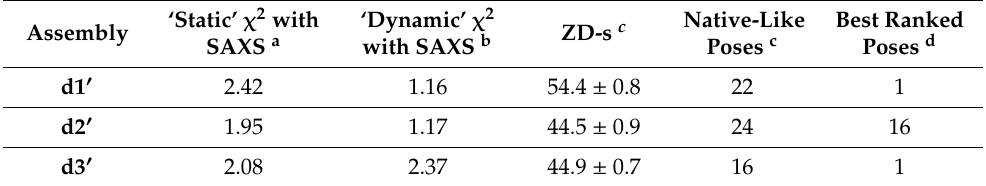
Table 2. Agreement with SAXS data and ZDOCK analysis and for the 3 selected models d1 (cid:48) ,d2 (cid:48) ,d3 (cid:48) . ‘Static’ χ 2 with ‘Dynamic’ χ 2 Assembly SAXS a